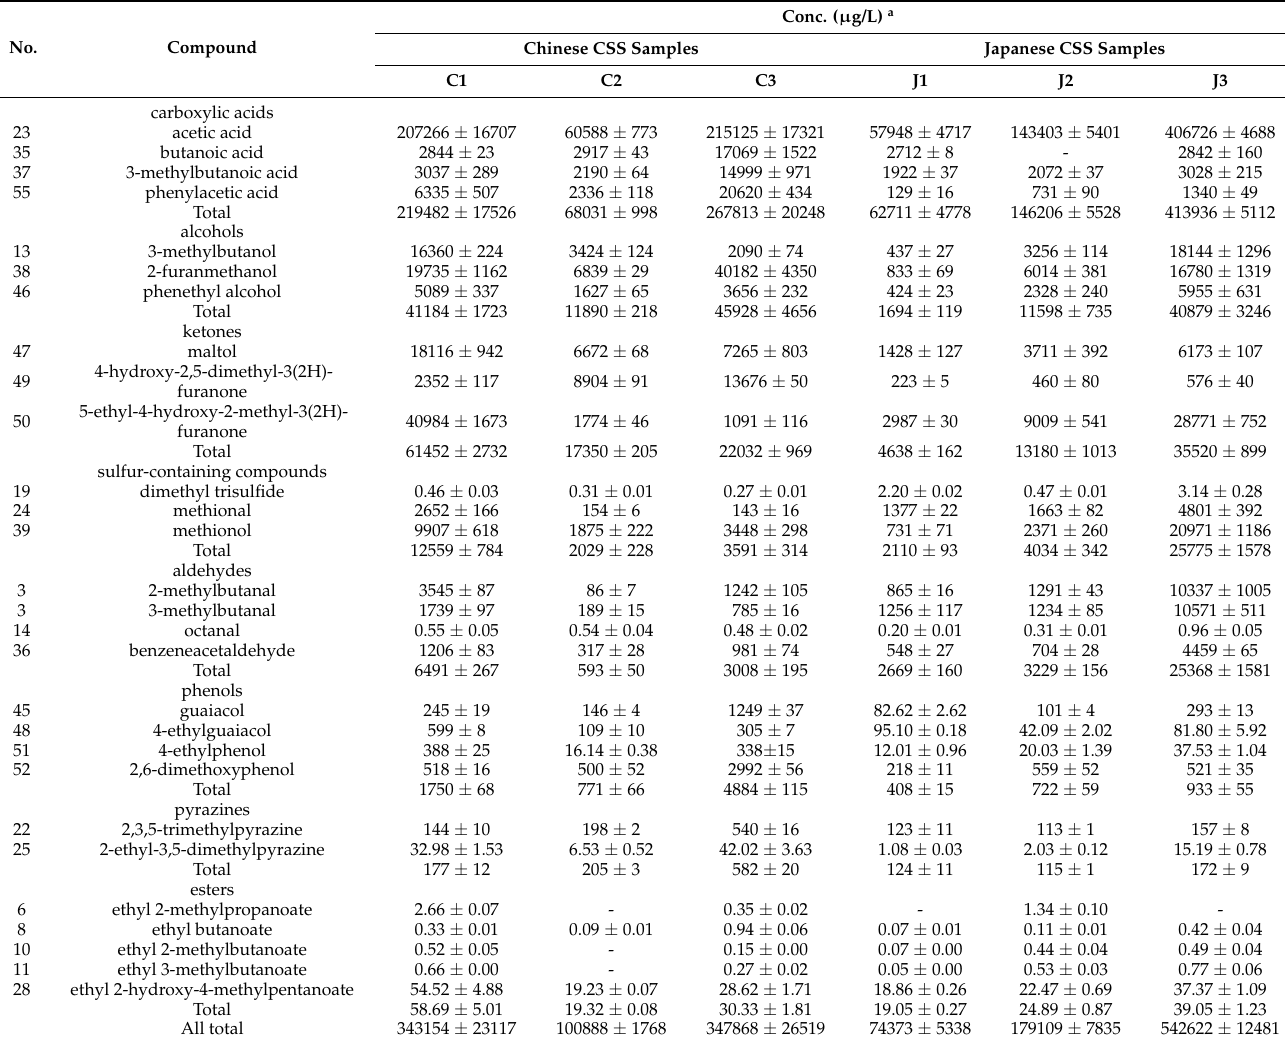
Table 4. Concentrations of 28 odor-active compounds in six CSS